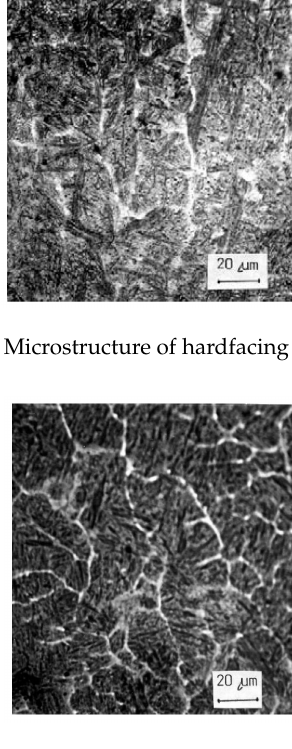
Figure 6. Thermally affected structure of the cladding E 508 B.